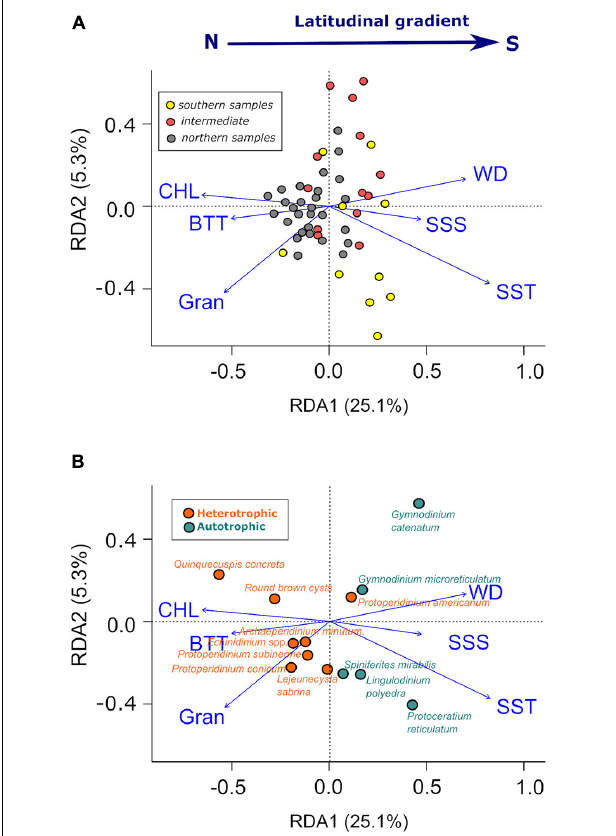
FIGURE 9 | Ordination of samples and environmental parameters (A) , and cyst taxa and environmental parameters (B) . The three groups defined by cluster are represented by different colors (A) . Only the most significant cyst types (those with the highest RDA1 and RDA2 values) are represented (B)